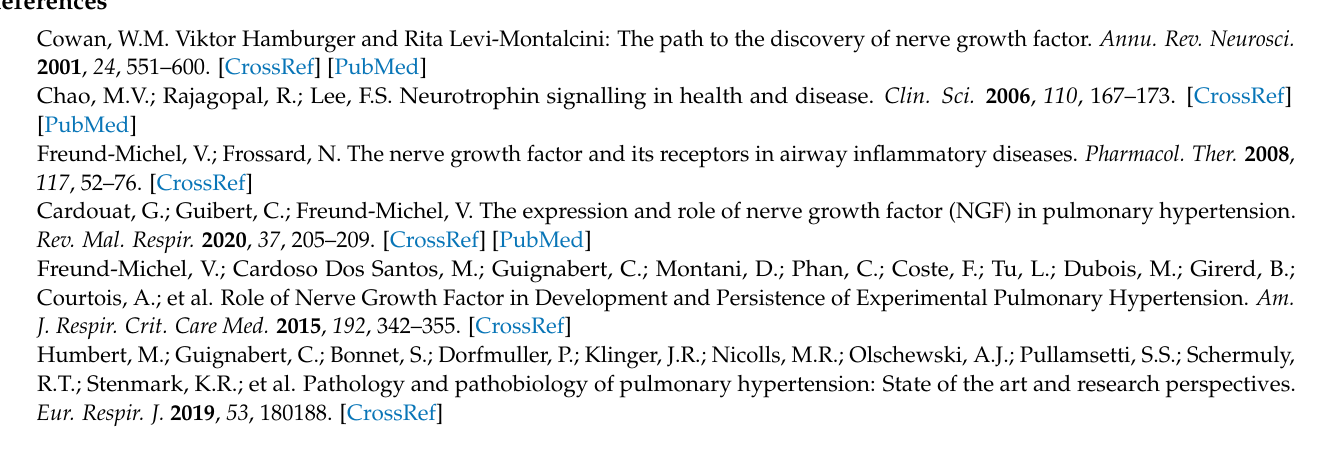
Figure S5: TGF- β 1 secretion triggered by IL-1 β or H 2 O 2 in human pulmonary arterial cells after pre-treatment with anti-NGF blocking antibodies; Figure S6: NGF secretion by human pulmonary arterial cells after treatment with TNF- α ; Figure S7: NGF secretion by human pulmonary arterial cells placed under hypoxic